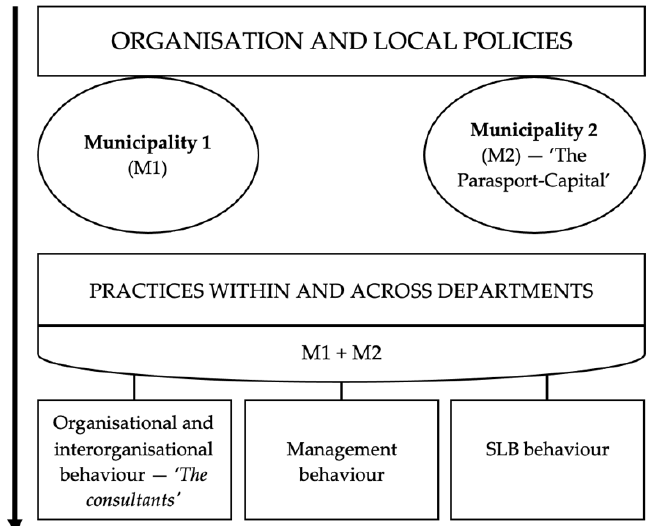
Figure 2. Structure of study findings .